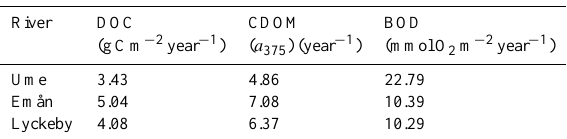
Table 4. Areal annual loadings of organic matter for the three catch-